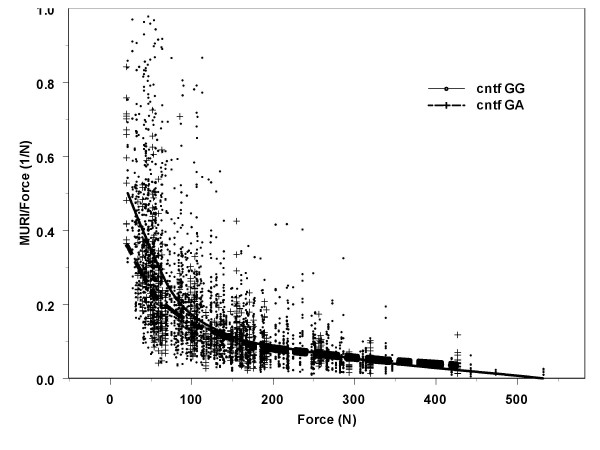
Relationship between knee extension force and relative number of motor units active per unit force (MURI/force) for CNTF GG and GA genotypes. Data represent individual measurements with a loess regression line for each genotype. Statistical analyses are given in Table 3.